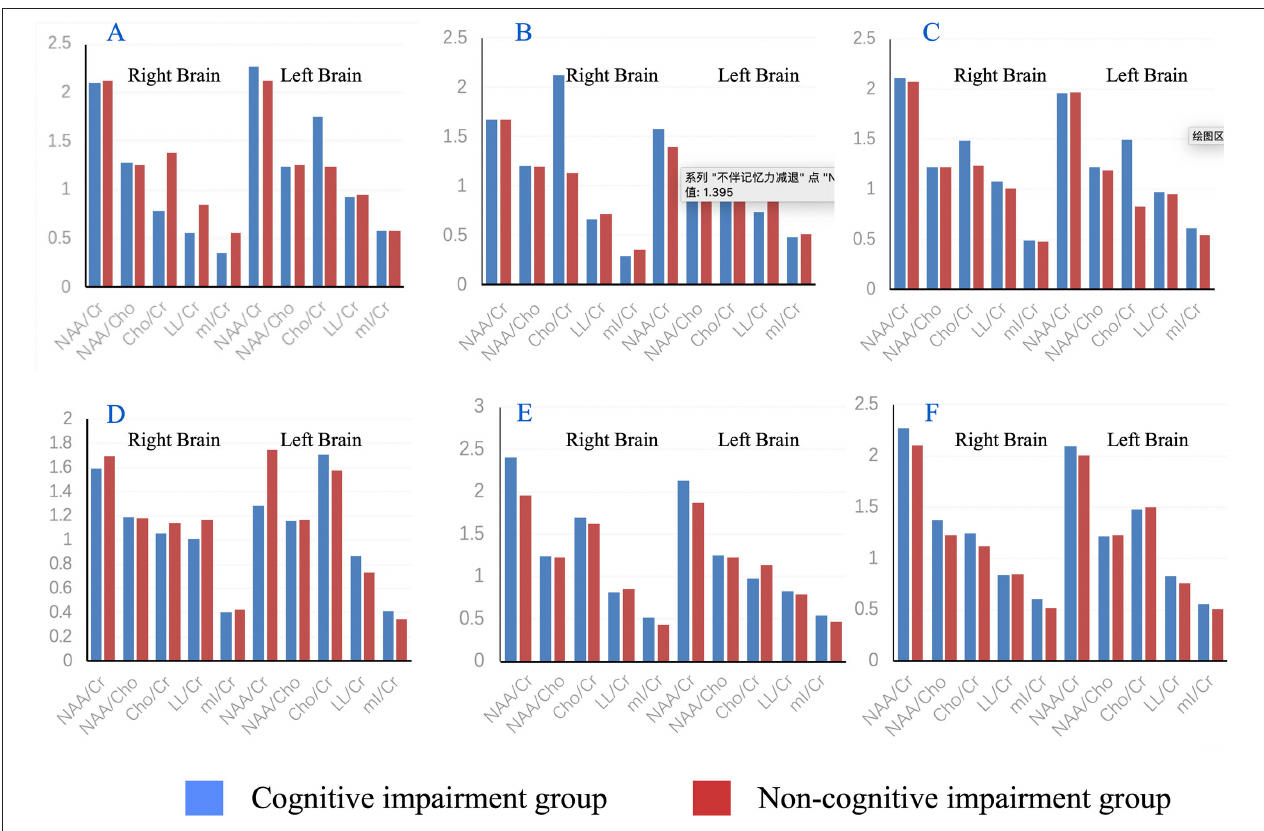
FIGURE 4 | Histogram of mean metabolite results in substantia nigra (A) , pallidum (B) , thalamus (C) , prefrontal cortex (D) , hippocampus (E) and parahippocampal gyrus (F) with comparison between the cognitive impairment group and non-memory impairment